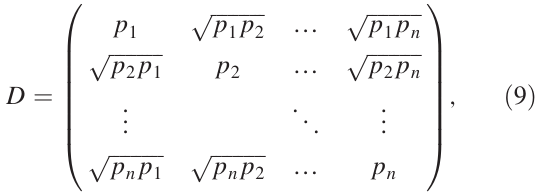
Fig. 1. Data close to the barrier ( d ≪ 1 ) indicate a class populated by students who are very similar to each other and (typically) exist in mixed model states individually; data closer to the origin indicate a class populated by students who are less similar to each other and may exist in